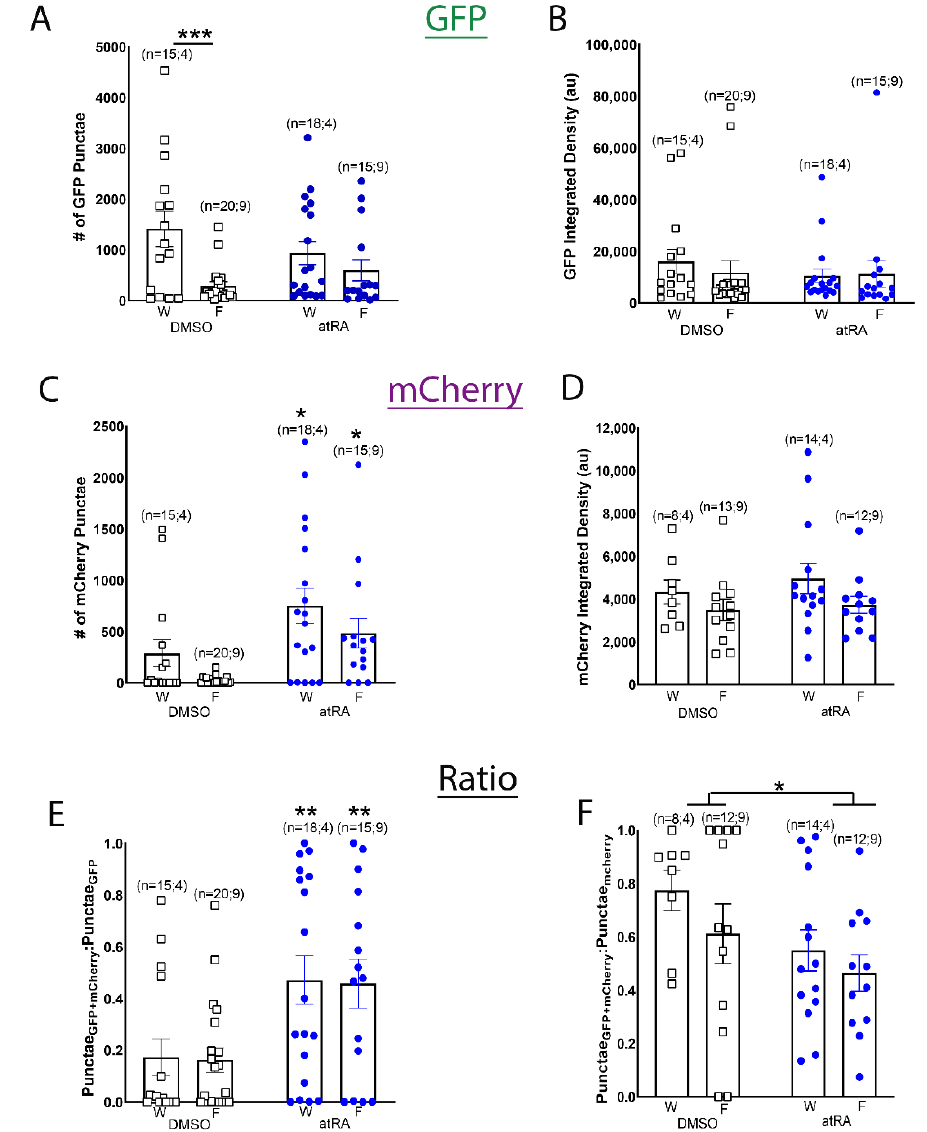
Figure 3. Quantification of GFP and mCherry expression following heat-shock and exposure of Drosophila CNS to either 10 µ M all- trans RA or 0.1% DMSO. ( A ) There is no significant difference in the number of GFP punctae between all- trans RA (atRA) and DMSO treatments, though CNS incubated in 0.1% DMSO show a significant difference between wandering (W) and foraging (F) larvae. ( B ) There is no significant difference in the GFP integrated density, either between atRA and DMSO treatments, or between wandering and foraging larvae. ( C , D ) There is a significant increase in the number of mCherry punctae following atRA treatment compared to DMSO ( C ), though no significant difference in the integrated density ( D ). ( E ) The proportion of GFP punctae that contain mCherry is significantly increased following exposure to atRA, in both foraging and wandering larvae, compared to vehicle controls. These data demonstrate that atRA increases the number of cells in which the LymRXR sensor is transcriptionally active. ( F ) There is a significant difference in the proportion of mCherry punctae that contain GFP between DMSO and RA treatments. * p < 0.05; ** p < 0.01; *** p < 0.001. Numbers in brackets represent total number of CNS, followed by the number of separate trials (replicates).